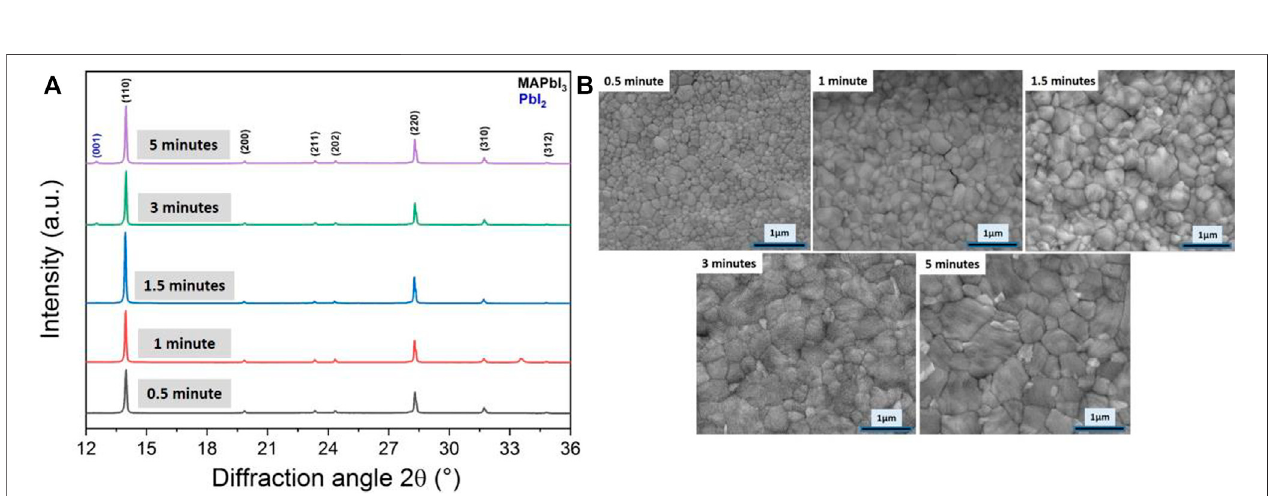
FIGURE 6 | (A) Evolution of X-ray diffractograms for a fi lm of MAPbI 3 post-annealed at 200 ° C for different times from 0.5 to 5 min, (B) High magni fi cation top-view SEM images of the corresponding fi lms.